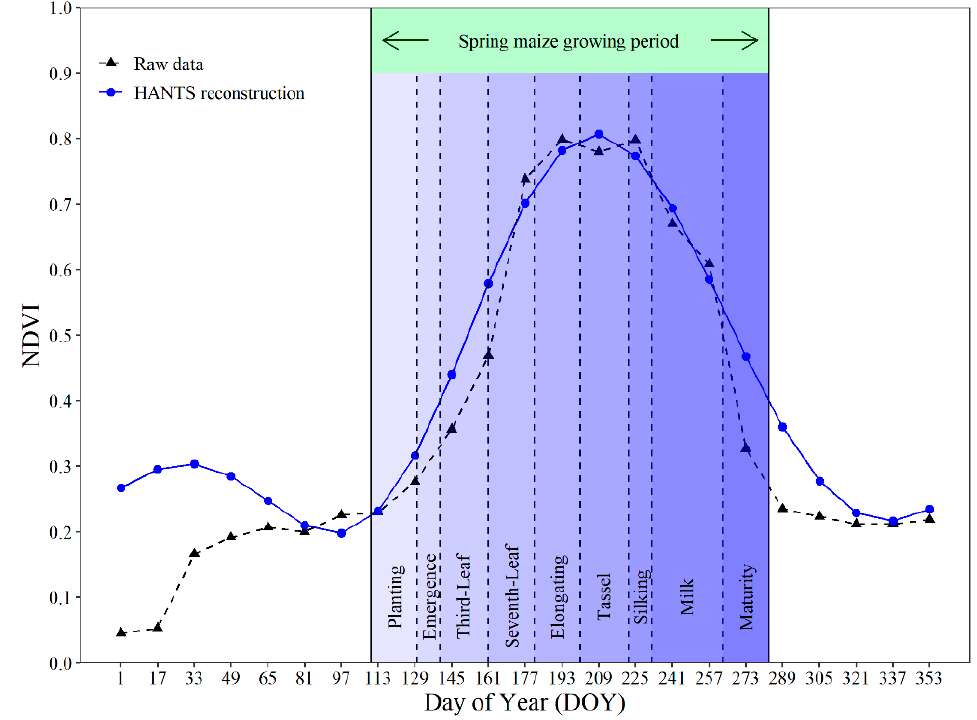
Figure 8. Comparison of before and after MODIS-NDVI time series reconstruction of spring maize. The construction of the decision tree for the extraction of the spring maize planting area in Jilin Province was based on the minimum and maximum time series curves of NDVI for the period of 2001 to 2016. A total of 13 images of NDVI values reconstructed by HANTS using a day-of-year (DOY) calendar from DOY 113 to 305 over 16 years were selected for this study. The pixels between the minimum and maximum NDVI values of the corresponding DOY were the candidate areas for the spring maize planting